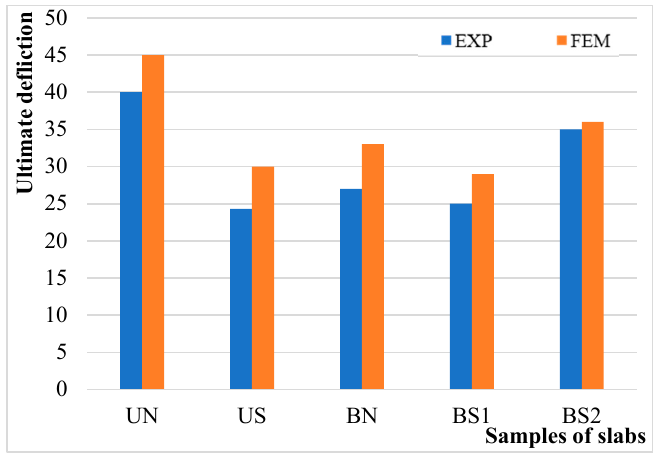
Figure 26. Ultimate deflection comparison between FEM and EXP.